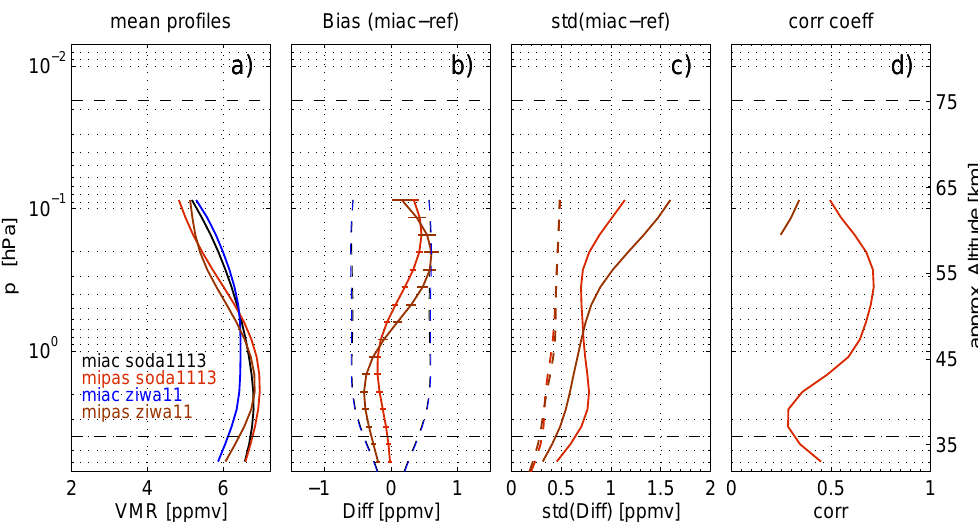
Fig. 12. Intercomparison MIAWARA-C – MIPAS for Sodankyl¨a11–13 (red) and Zimmerwald11 campaign (brown). (a) Mean coincident pro- files for Sodankyl¨a11–13 (MIPAS: red, MIAWARA-C: black) and for Zimmerwald11 (MIPAS: brown, MIAWARA-C: blue). (b) Bias (solid, Sodankyl¨a11–13: red, Zimmerwald11: brown) with standard error (horizontal) together with the estimated systematic error of MIAWARA-C (Sodankyl¨a11–13: black, Zimmerwald11: blue). (c) Standard deviation of differences (solid) and combined random error of the instruments (dashed), red for Sodankyl¨a11–13 and brown for Zimmerwald11 campaign. (d) Correlation coefficients. All plots use MIAWARA-C data with AoA > 0.5. The dashed horizontal lines indicate the reliable altitude range (AoA >